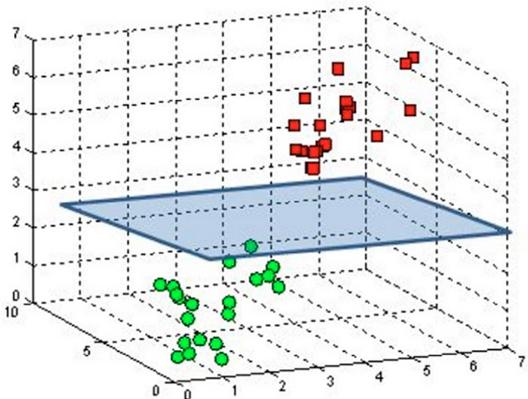
Figure 3. Classi fi cation of SVM with Hyperplanes as Class 0 and Class 1. Figure 3. Classification of SVM with Hyperplanes as Class 0 and Class